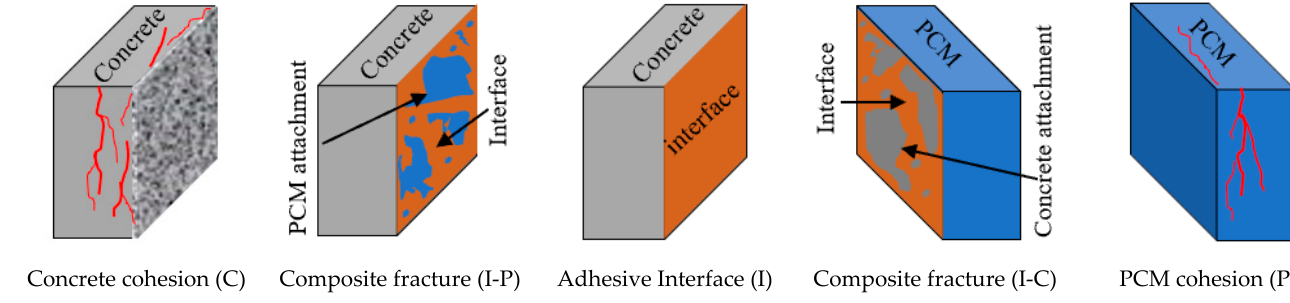
Figure 10. Classification of the fracture surface of the composite specimens.